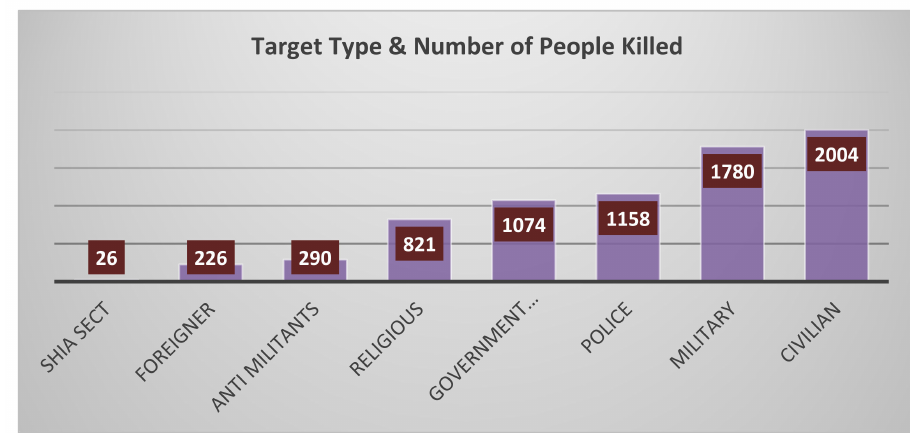
Figure 3. Visual analysis of the distribution of target type and ratio of people killed.